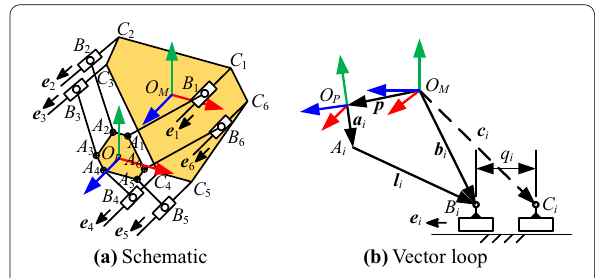
Figure 3 6-PSU parallel manipulator